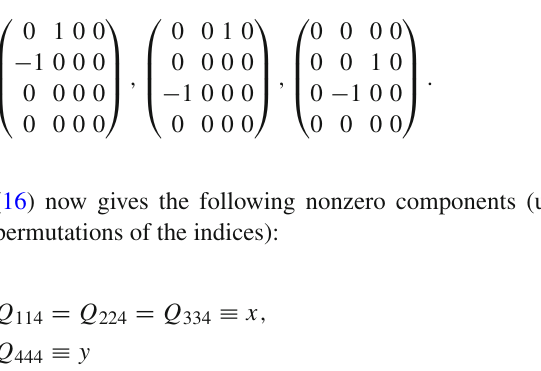
Fig. 3 Numericalintegrationoftheintegralin(39)with x 1 = 0 . 3 , y = − 1 ,ε = 0 . 0001. The figure plots the values of | Ψ( z z 1 , z 2 , where x 2 = x 1 + z 1 , x 3 = x 1 + z 2 . We used a step of Δ z 1 , 2 = 0 . 001. The function peaks around z 1 = z 2 = 0, which is the SO ( 3 ) peak, and there are also smaller SO ( 2 ) peaks along z 1 = 0, z 2 = 0, and z 1 = z